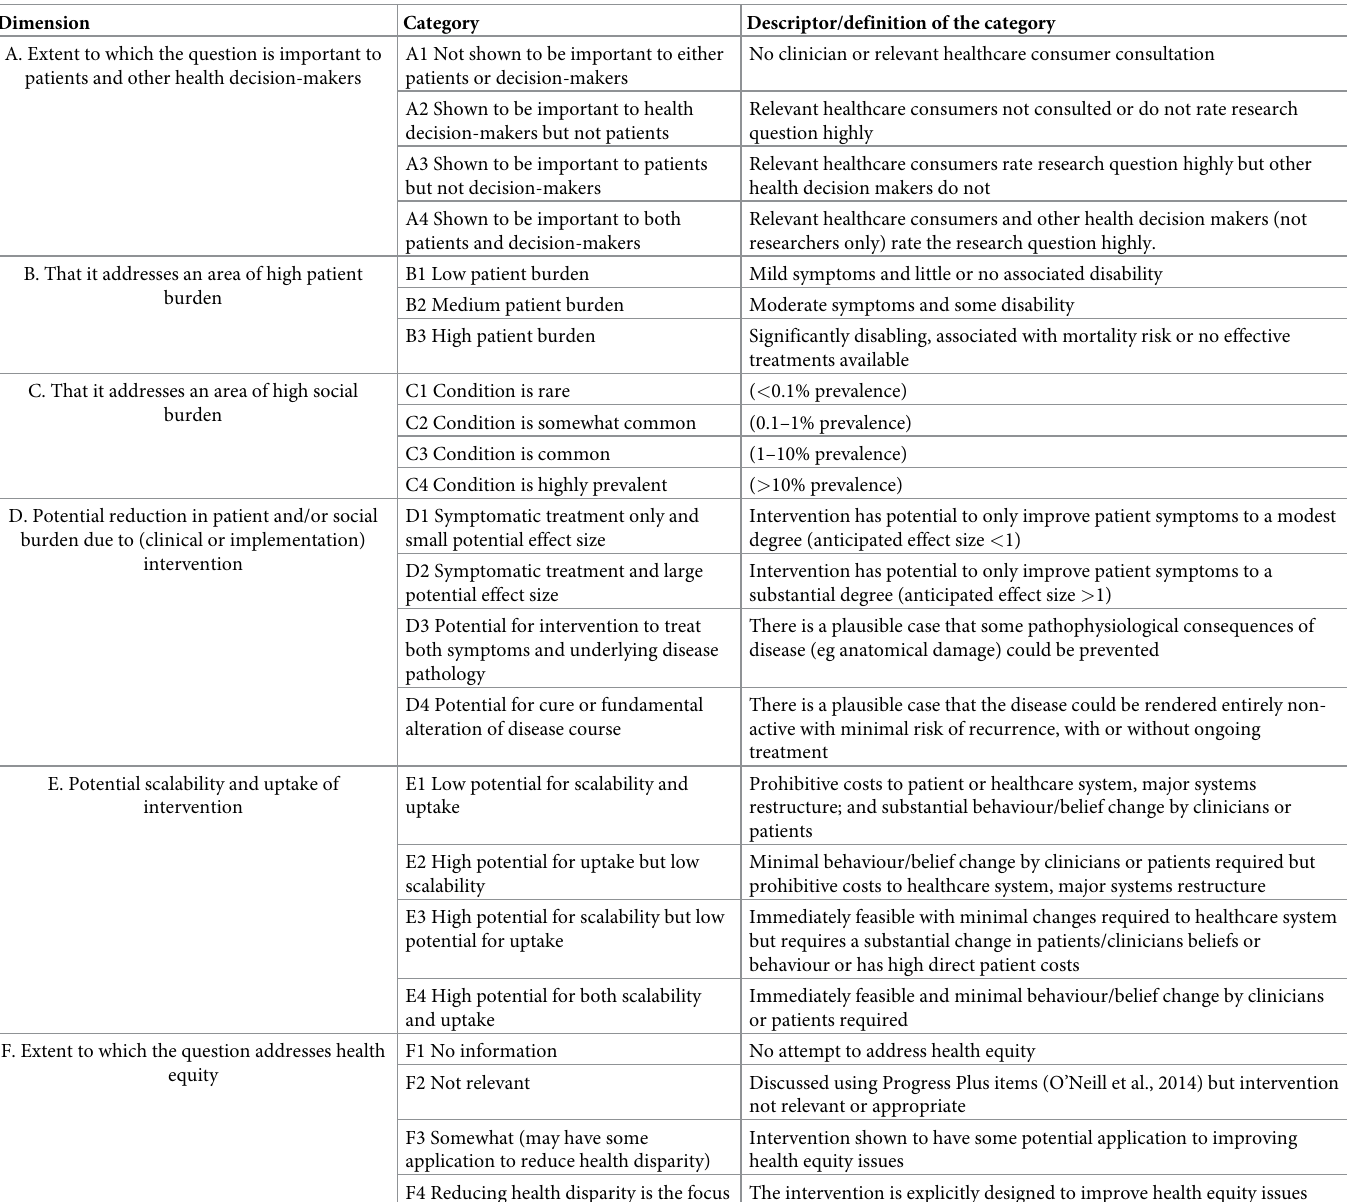
Table 2. Research Question Importance Tool